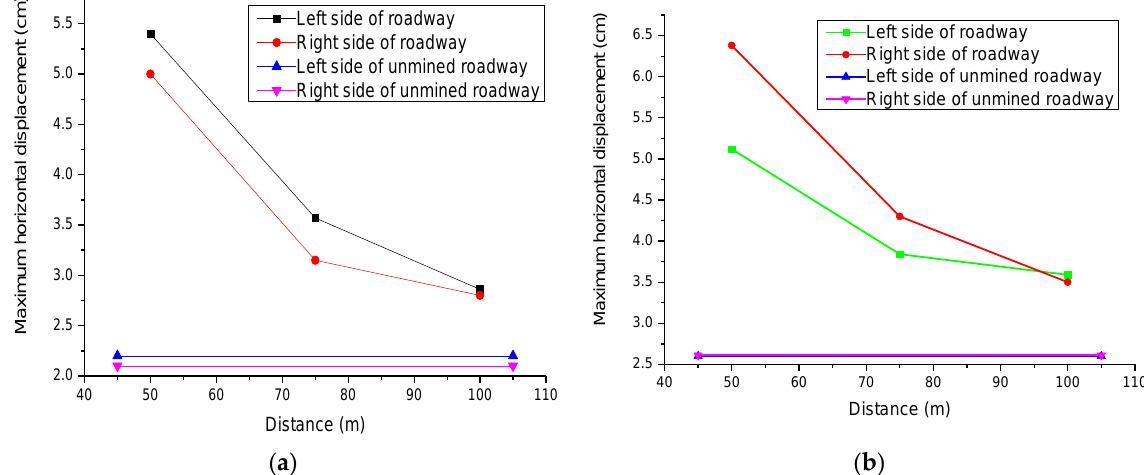
Figure 15. Maximum vertical displacement at different positions of working face and roadway: ( a ) the track roadway and ( b ) the auxiliary transportation roadway.